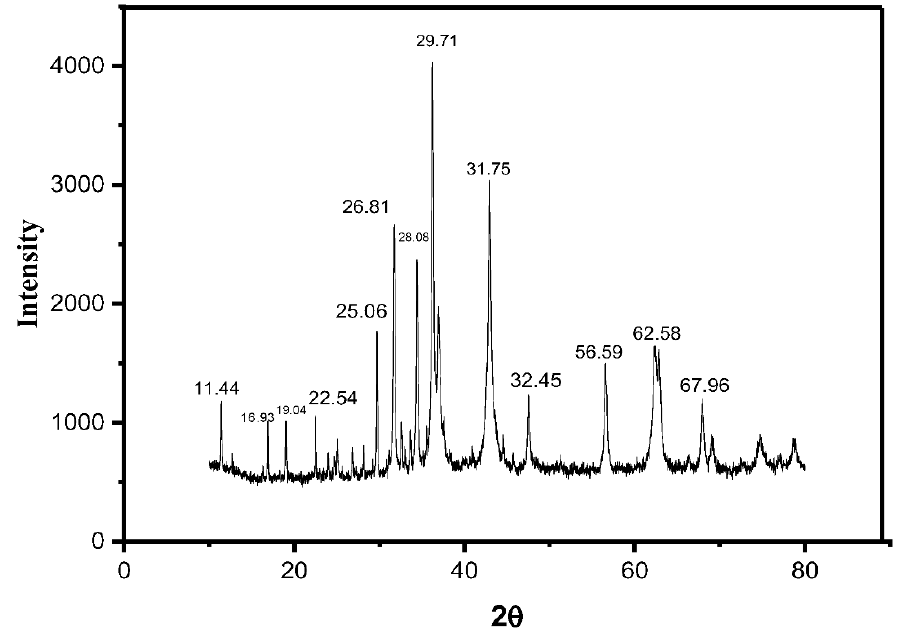
Figure 6. XRD spectrum of the designed photocatalyst.